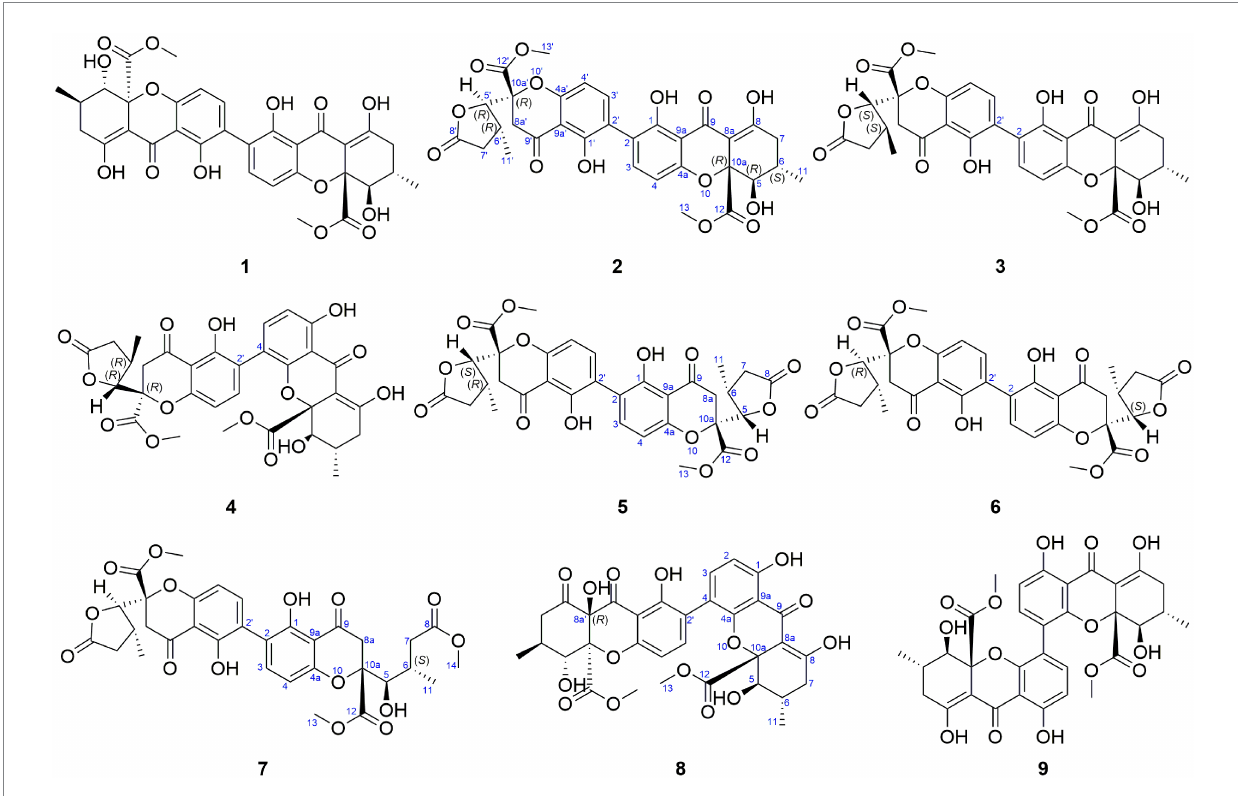
FIGURE 1 Structures of dimeric tetrahydroxanthones 1 – 9